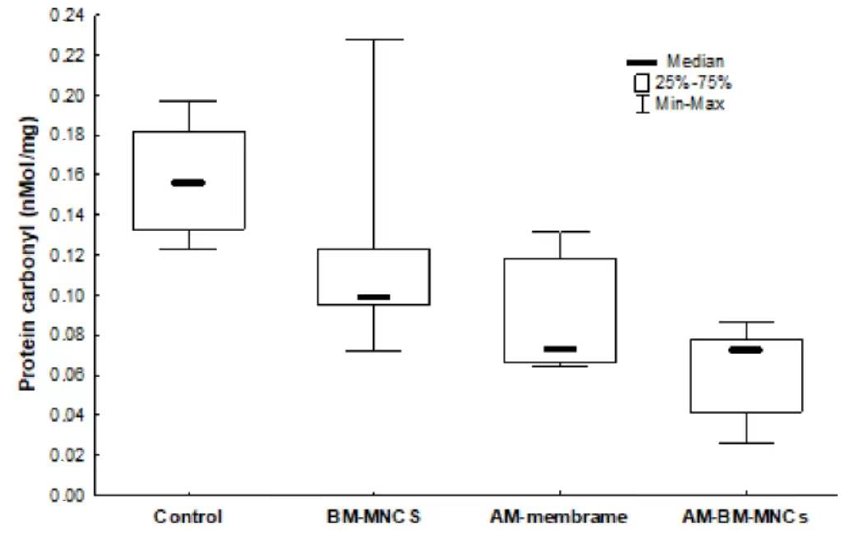
Figure 8. Effect of AM and BMSCs on carbonyl activity. Results are expressed as mean [interquartile range] ± SEM (N = 10). p < 0.05 denoted statistical significance in comparison to the control group. BMSCs: bone marrow mononuclear stem cells; AM : acellular human amniotic membrane.